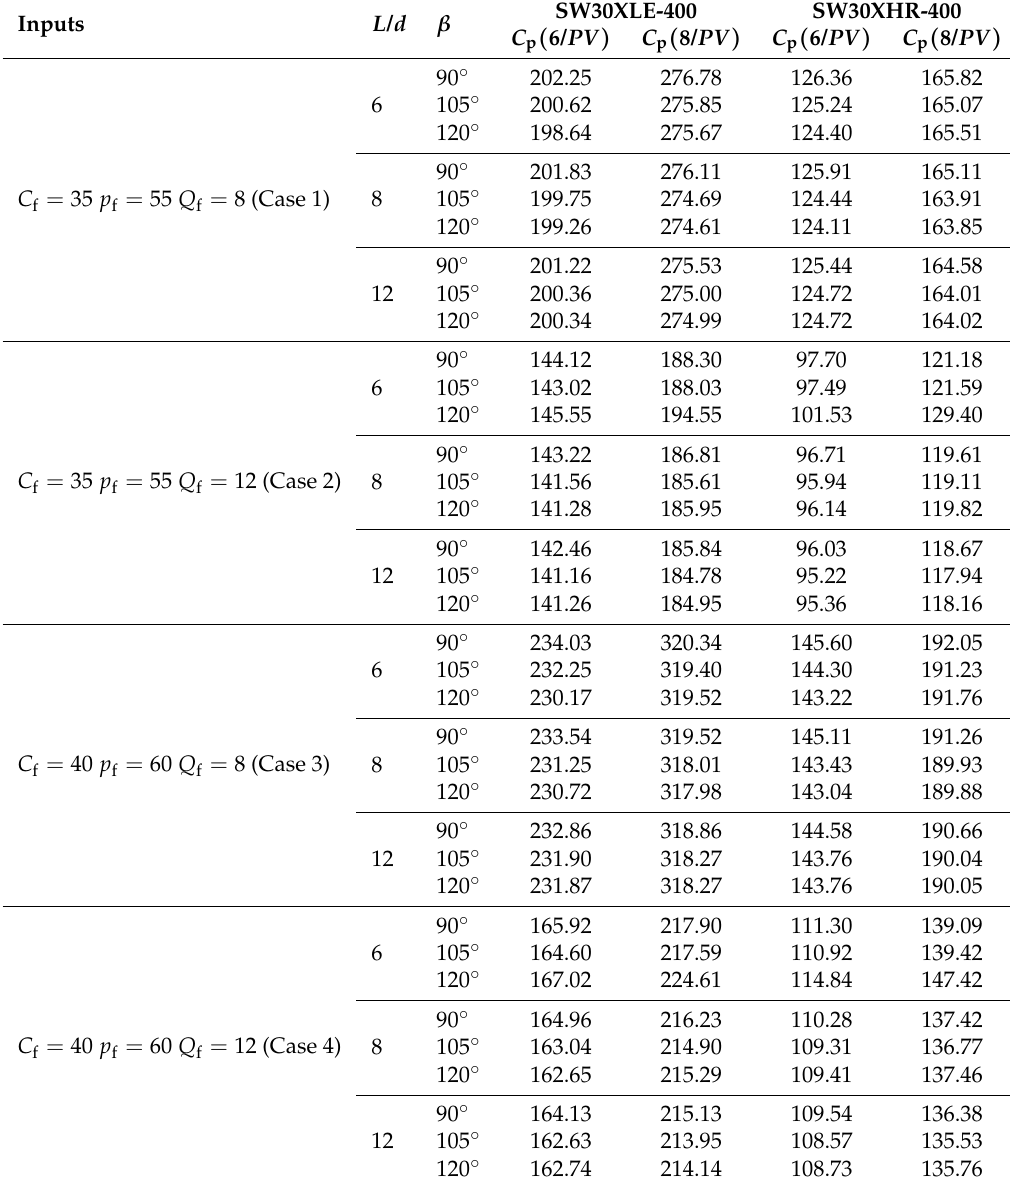
Table 6. C p (mg L − 1 ) for PVs of 6 and 8 SWMMs with the two membranes studied with different FSGs. SW30XLE-400 SW30XHR-400 Inputs L / d β C p ( 6/ PV ) C p ( 8/ PV ) C p ( 6/ PV ) C p ( 8/ PV )